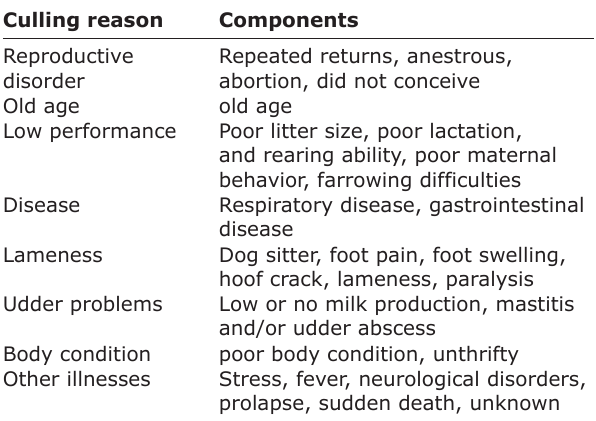
Table-1: The culling reason are divided into categories.